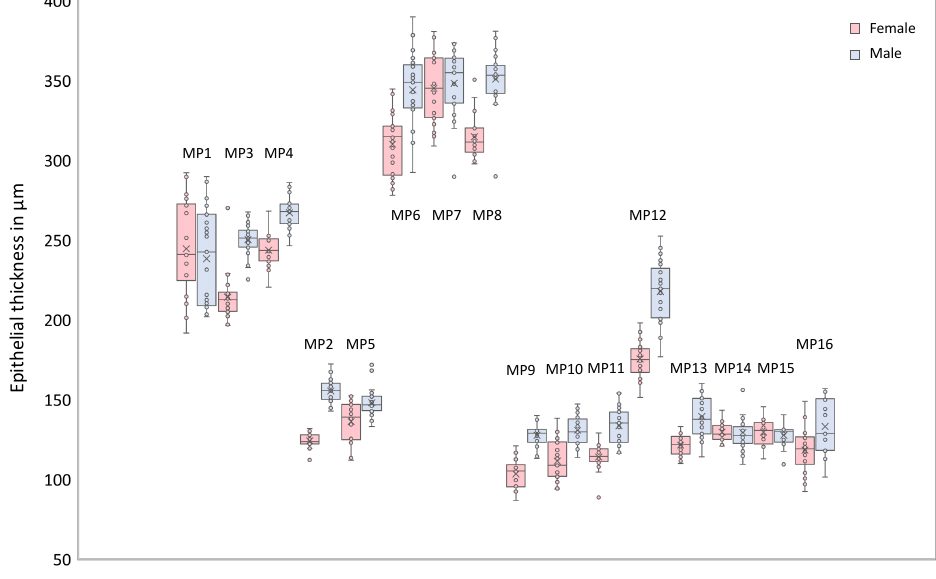
Figure A2. Box plot of the gender-specific epithelial thickness according to the location. Labial: MP1/MP3/MP4, Alveolar: MP2/MP5, Buccal: MP6-MP8, Sublingual: MP9/MP10, Mouth floor: MP11, Hard palate: MP12, Soft palate: MP13, Uvula: MP14, Oropharynx: MP15, Tonsils: MP16 (cp. Figure